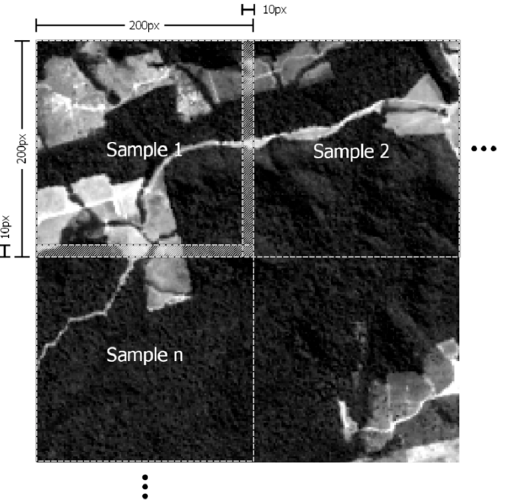
Figure 3. Example of the patch extraction method to prepare the datasets for the deep learning (DL) algorithms.